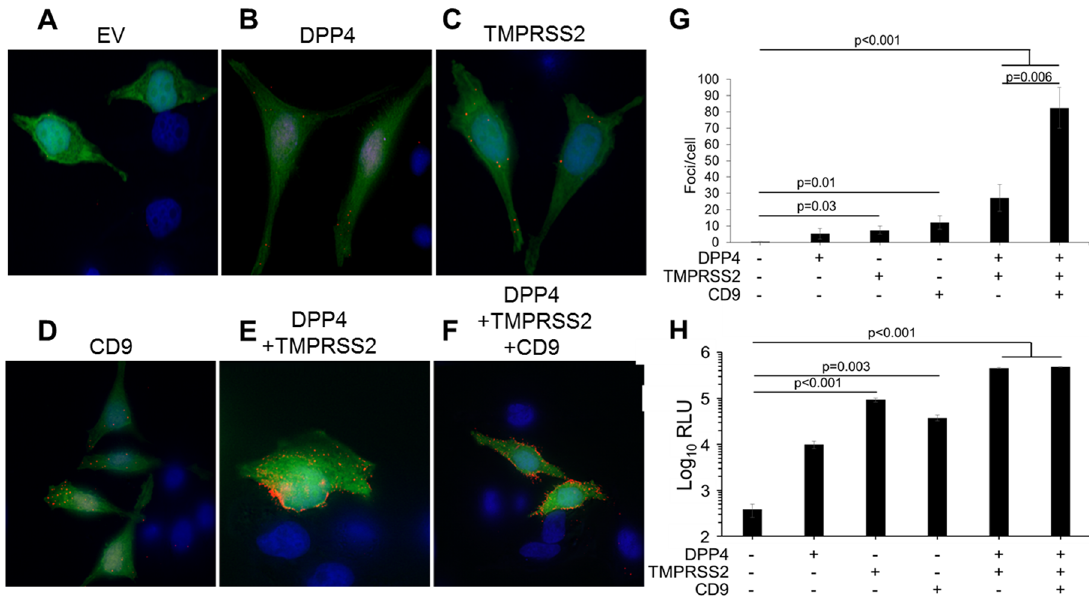
Fig 3. Proximity ligation assay of DPP4 and TMPRSS2 in CD9KO cells. (A-F) HeLa CD9KO cells were transfected with the indicatedgenesand a GFP reporter before being mountedon microscopy slides. Proximity ligationassay was performed using primary antibodiesagainst hDPP4 and hTMPRSS2. Red foci indicateclose proximity of the two proteins. (G) The average number of foci/cell in GFP + cells in each group was quantified.(H) MERSpp transduction of HeLa cells overexpressing the